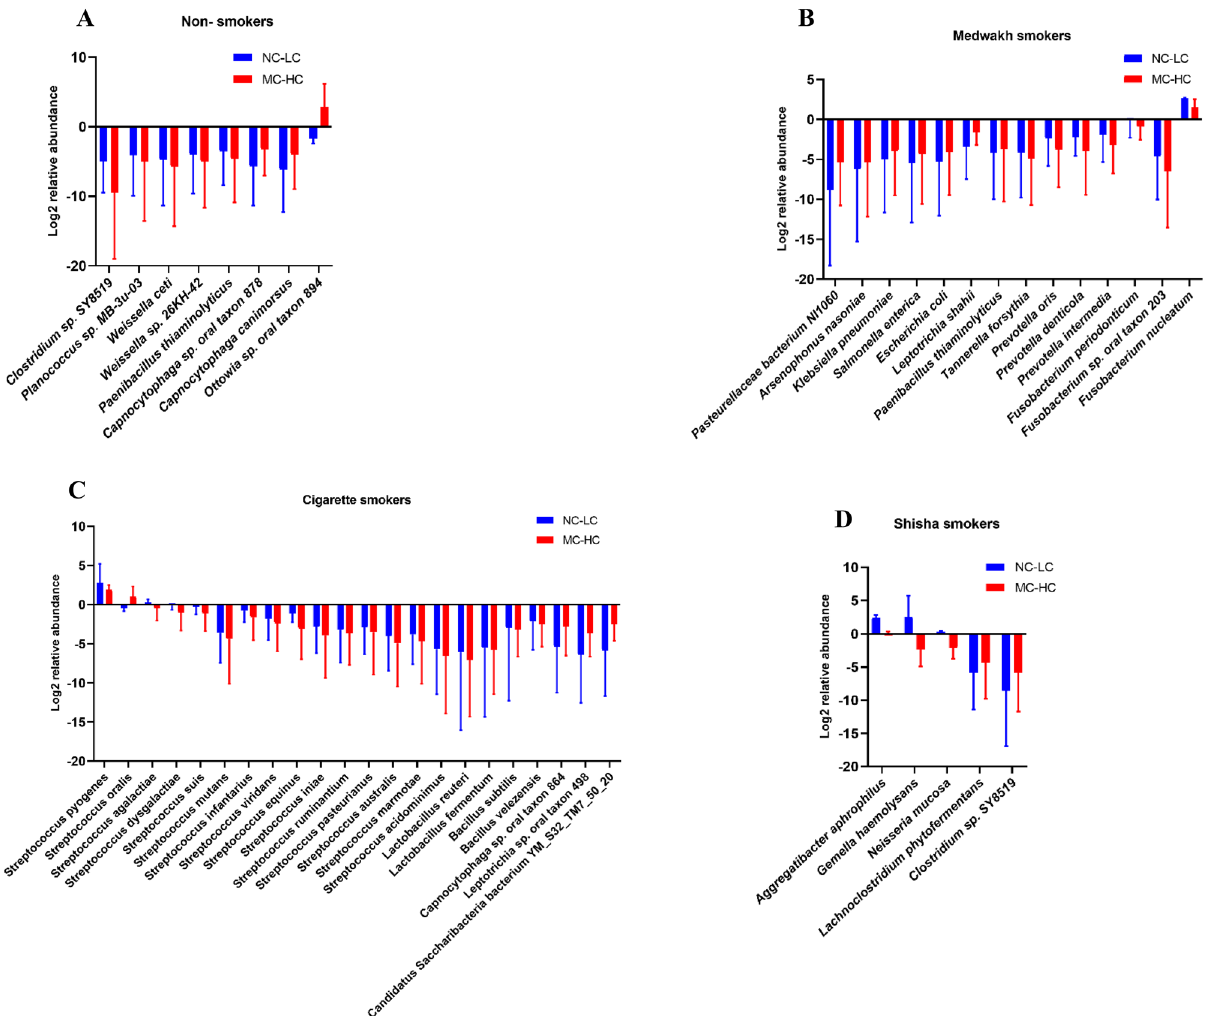
Figure 4. Comparison of the relative abundance (%) of species detected in the supragingival plaque samples collected from patients with no or low (NC-LC) caries and moderate-high (MC-HC) caries, in smokers of different types of tobacco (3B, 3C, 3D) and non-smokers